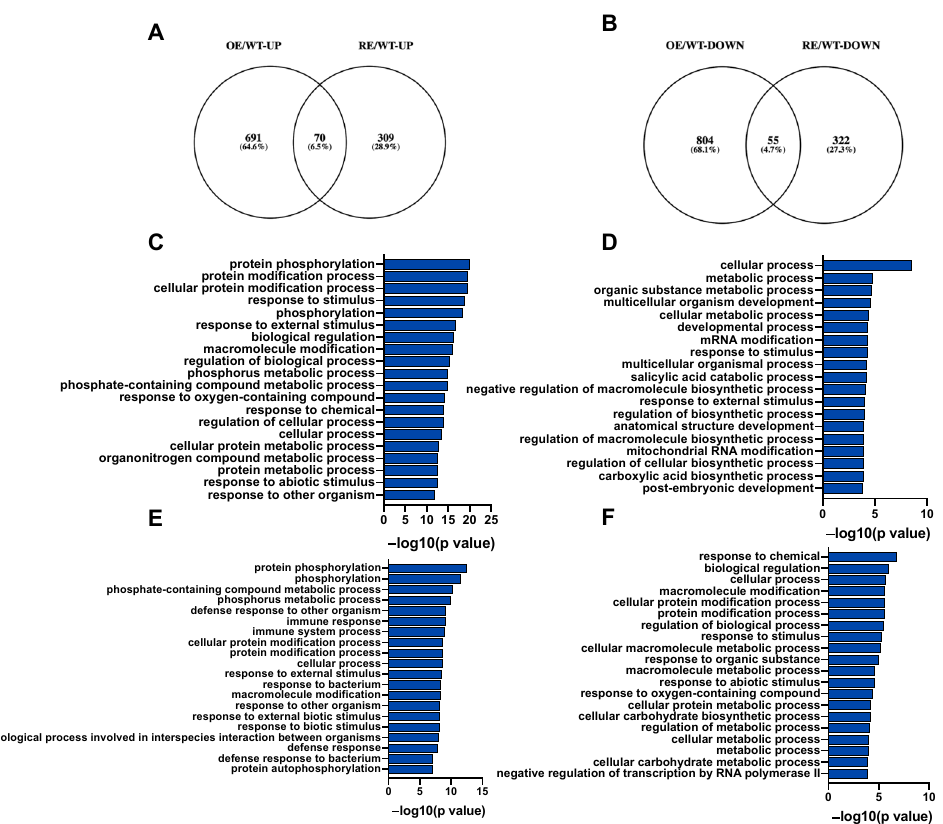
Figure 2. Transcriptome analysis of PsnWRKY70 transgenic lines infected with A. alternata . ( A ) Venn diagram of upregulated DEGs between OE and RE. ( B ) Venn diagram of downregulated DEGs between OE and RE. ( C ) GO enrichment analysis of uniquely upregulated genes in OE lines. ( D ) GO enrichment analysis of uniquely downregulated genes in OE lines. ( E ) GO enrichment analysis of uniquely upregulated genes in RE lines. ( F ) GO enrichment analysis of uniquely downregulated genes in RE lines.